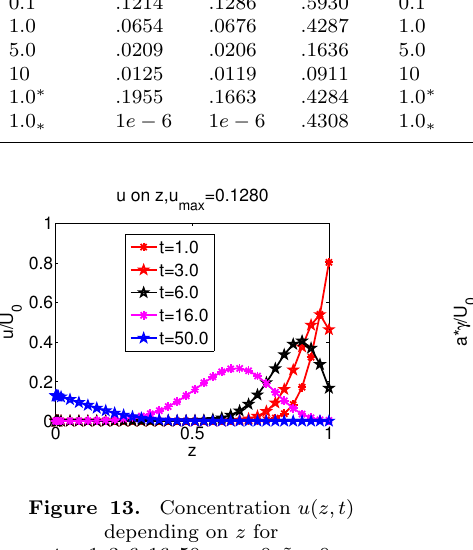
Figure 13. Concentration u ( z,t ) depending on z for